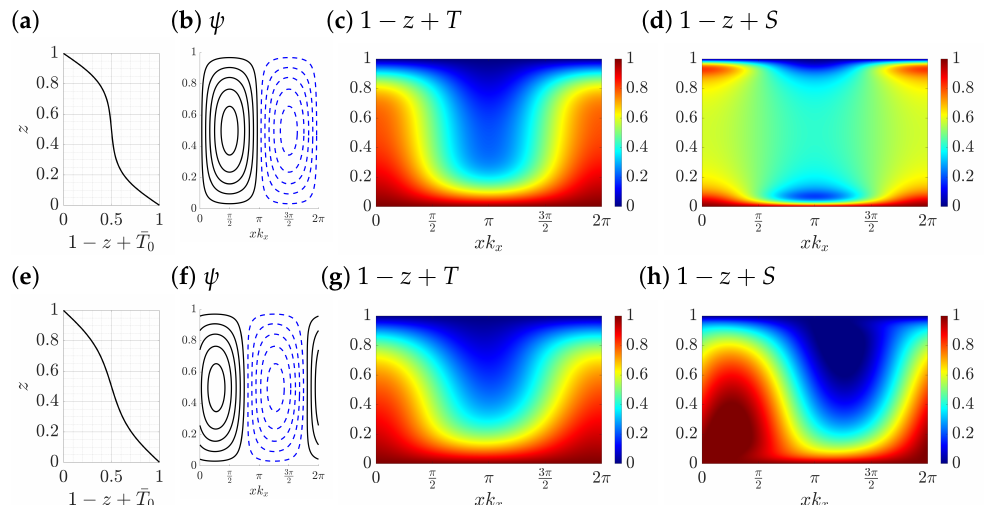
Figure 12. Top: unstable steady convection rolls from single-mode equations showing ( a ) mean temperature 1 − z + ¯ T 0 and isocontours of ( b ) streamfunction ψ , ( c ) total temperature 1 − z + T and ( d ) total salinity 1 − z + S . Bottom: stable left traveling wave convection in the comoving frame with phase speed c = − 5.31 from single-mode equations showing ( e ) mean temperature 1 − z + ¯ T 0 and isocontours of ( f ) streamfunction ψ , ( g ) total temperature 1 − z + T and ( h ) total salinity 1 − z + S . The parameters are Ra T = 100, R ρ = 0.4, Le = 20, k x = π and k y = 0.